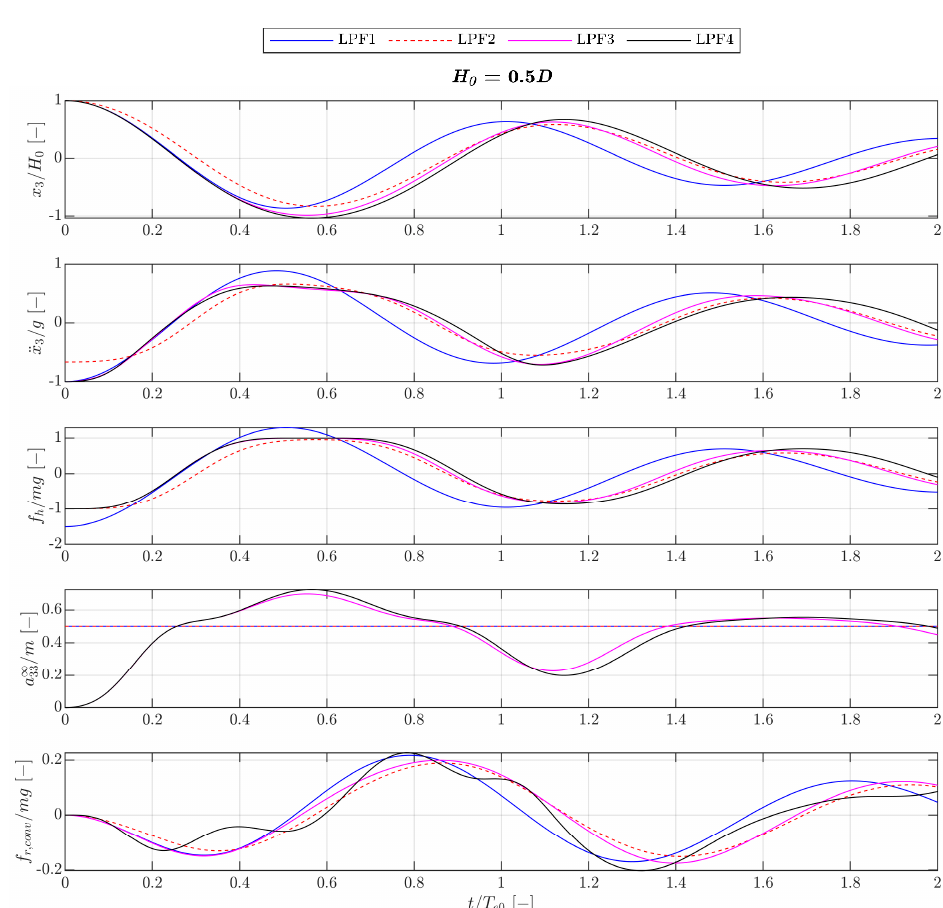
Figure A6. Results from the different LPF models for the first two natural periods.